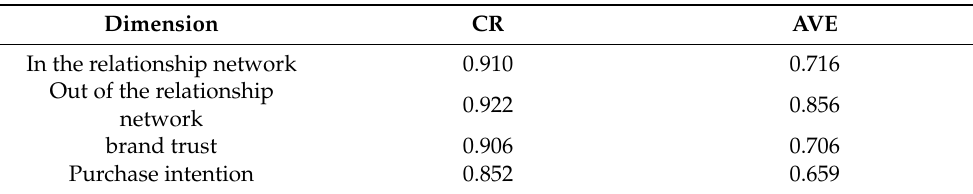
Table 3. Composite reliability and average variance